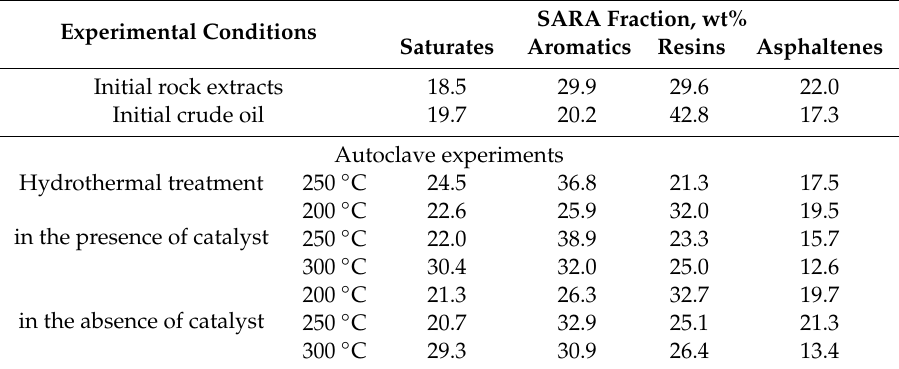
Table 1. SARA-analysis of extracts from reservoir rock.